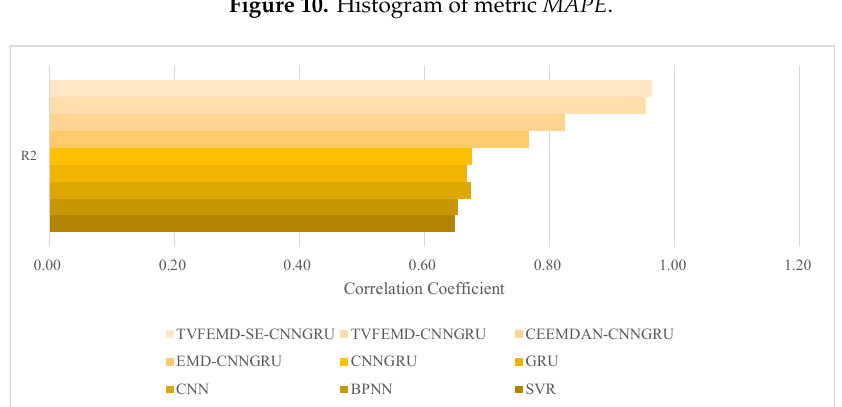
Water 2020 , 12 , x